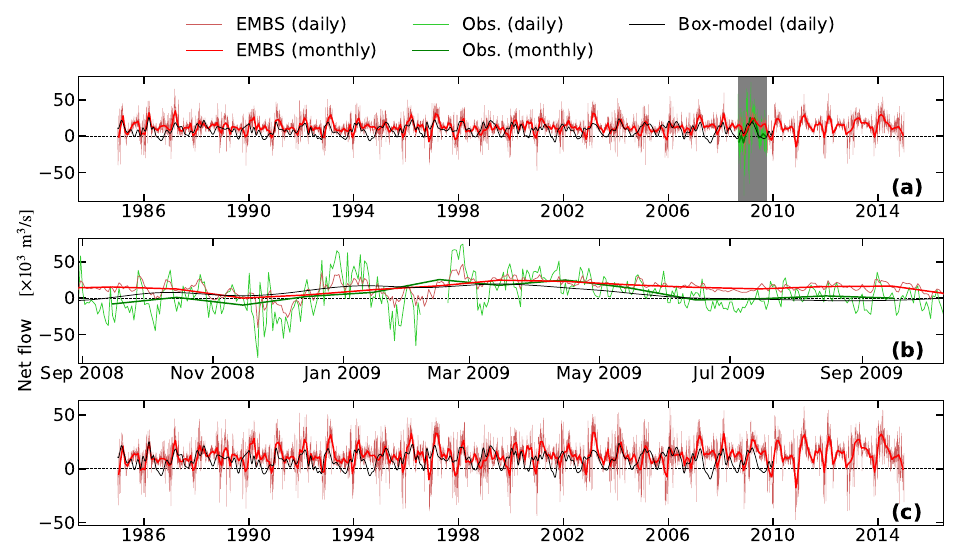
Figure 9. Time-series of net volumetric flow: ( a ) at Dardanelles, ( b ) at Dardanelles for the period denoted with the gray box, and ( c ) at Bosphorus. Comparison between the EMBS simulation, the model of Maderich et al., and 1-year-long observations at Dardanelles strait from Jarosz et al. described in Section 2.3, using daily values and monthly averages.